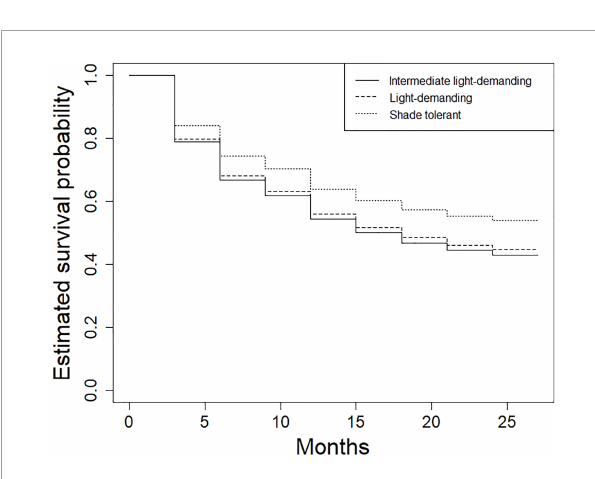
FIGURE6 Estimated survival probabilities of seedlings across shade-tolerance guilds in the Ngel Nyaki Forest Dynamics Plot from January 2018 to January 2020. The lines represent estimated survival average probabilities for the different groups. The survival functions were calculated using the Kaplan–Meier